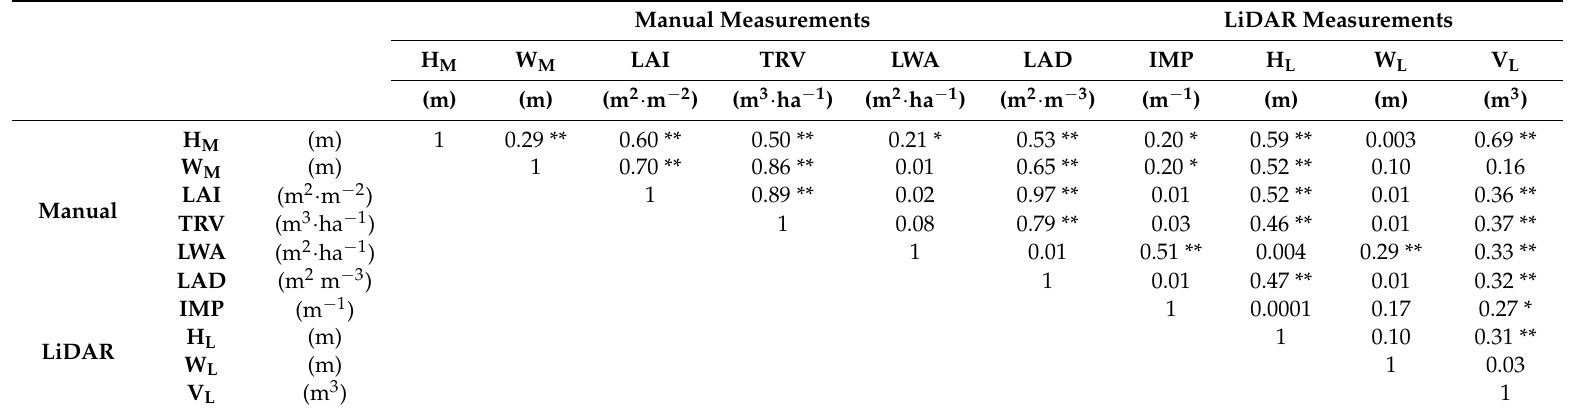
Table 3. All possible comparisons among all measured and calculated parameters related to the canopy volume and